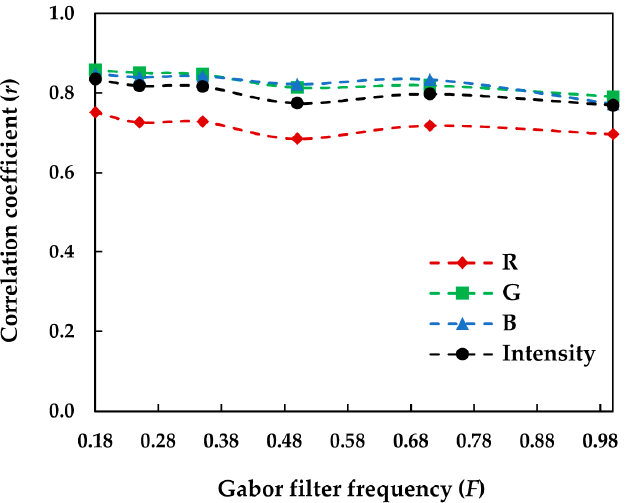
Figure 17. The correlation between the VRS Cpx of the textiles and rotation-invariant Gabor σ of the textile images in the sRGB space depends very slightly on the Gabor filter frequency ( F ).